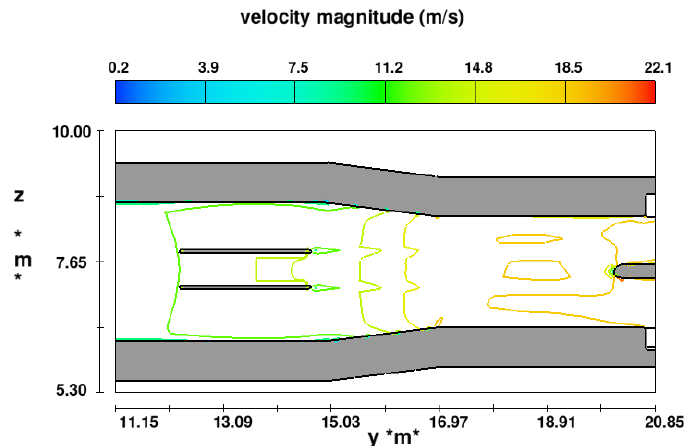
Figure 8. The Sectional view of velocity magnitude contours for the longitudinal distance between two valves = 3D.